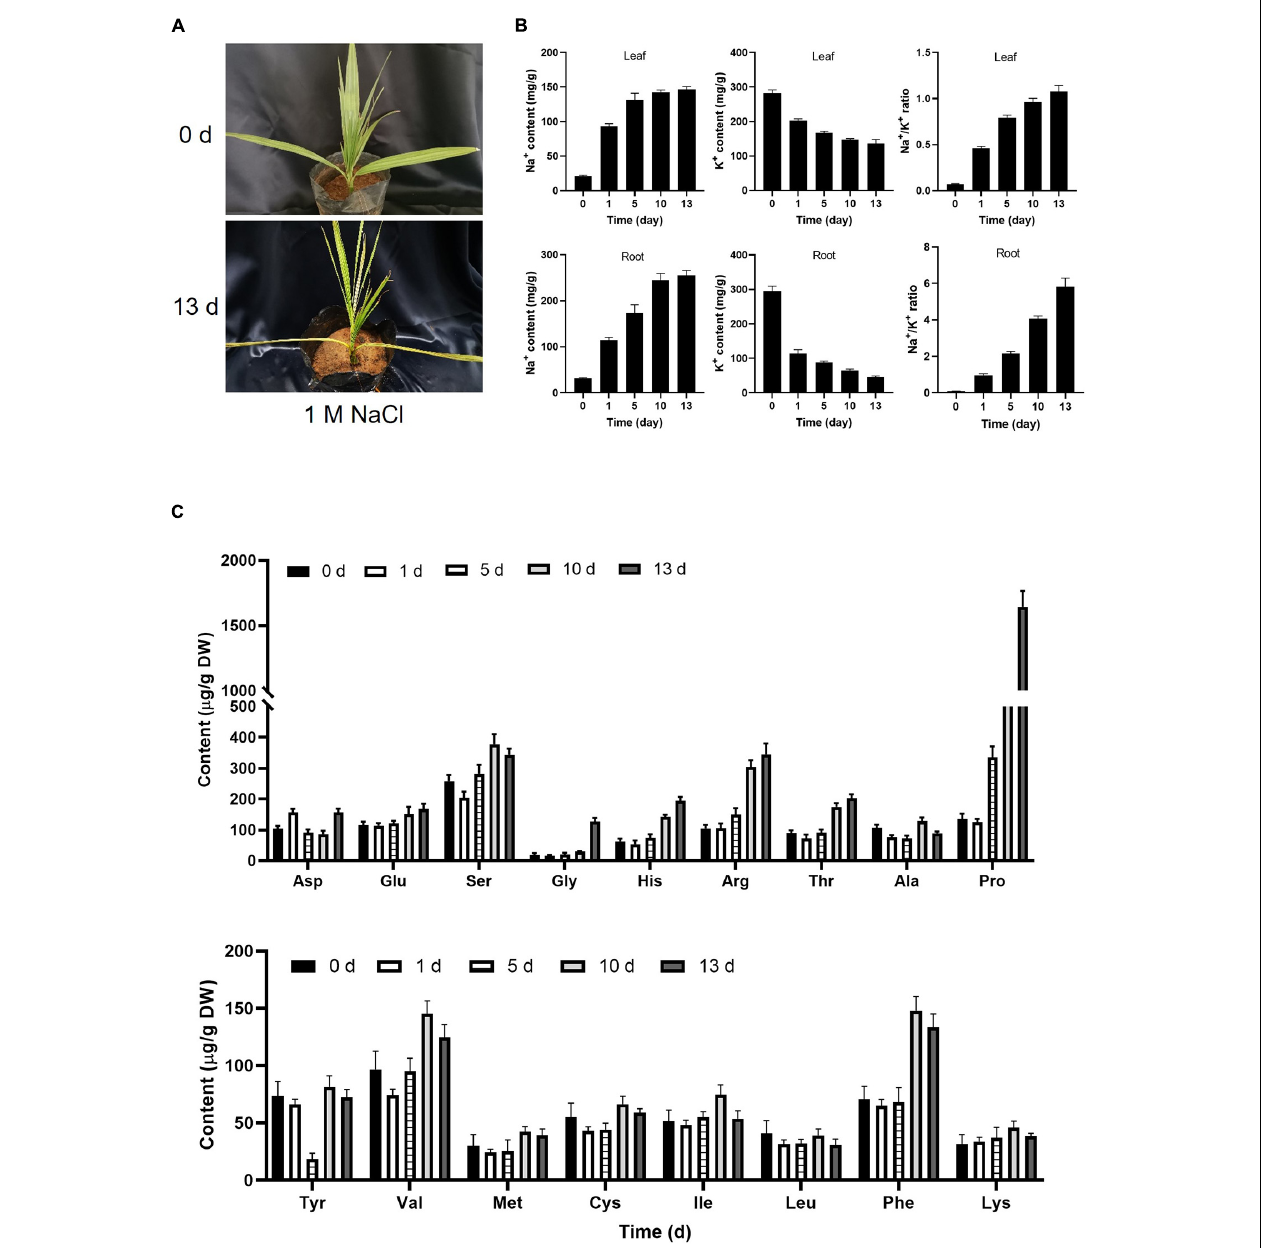
FIGURE 1 | Physiological changes of date palm in response to salt stress. (A) Represented images of 6-month-old date palm plants were subjected to salt stress for indicated time. (B,C) Concentration of Na + and K + and the content of amino acids in the date palm respond to salt stress. The 6-month-old date palm plants with similar size were subjected to 1 M NaCl solution for indicated time, and the leaves of the date palm trees with the same position were harvested for ion measurement (B) and amino acid profiles (C)